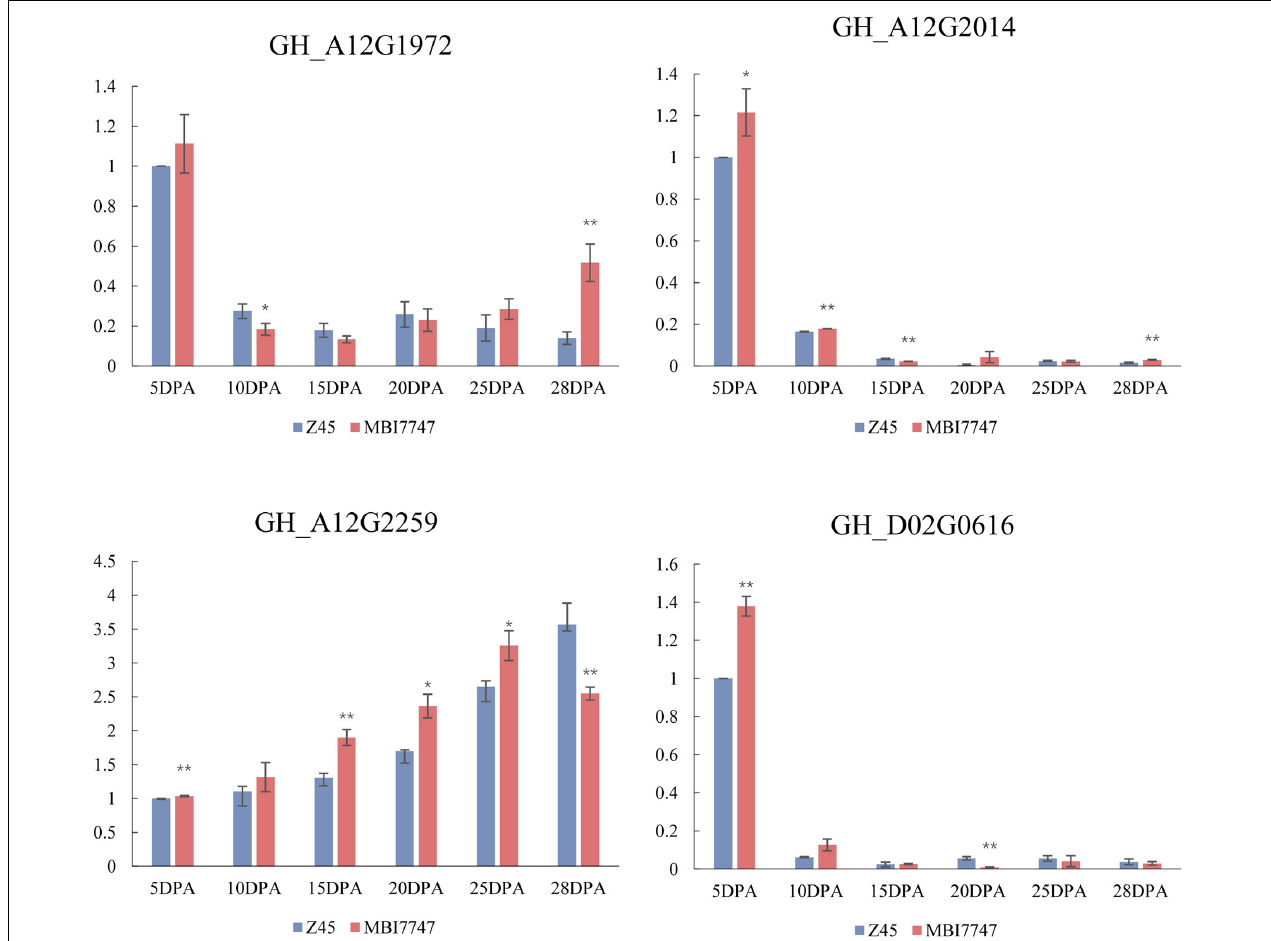
FIGURE 5 | qPCR analysis of transcript levels for four candidate genes over the course of fiber elongation in the two parental lines. Relative expression levels are shown on the Y -axis, while different DPA values over the course of fiber elongation are noted on the X -axis. Error bars correspond to standard error. *At the 0.05 level highly significant correlation; **at the 0.01 level significant